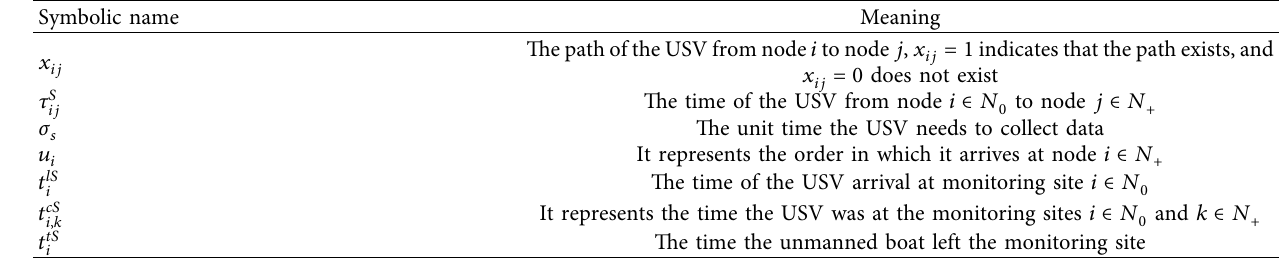
Table 1: Te symbol and variable table for USV.